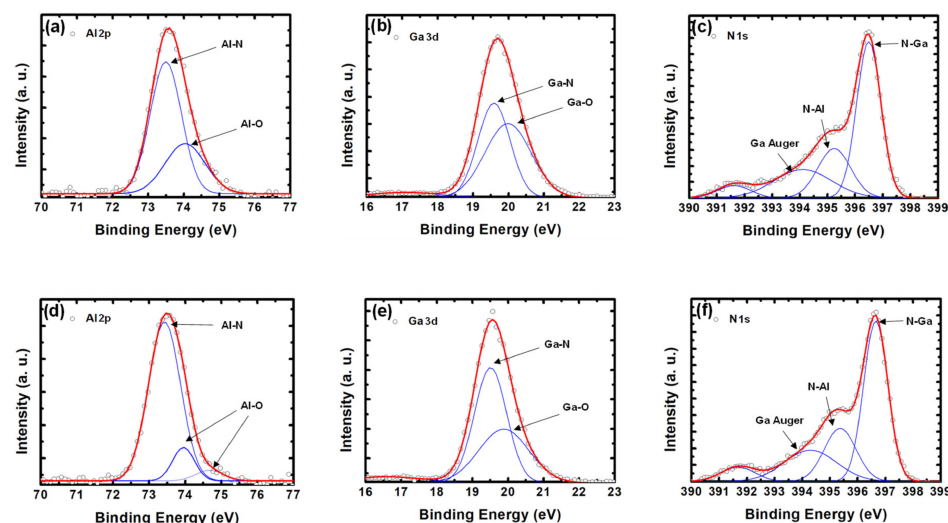
Figure 10. XPS fitting results of the Al 2 p , Ga 3 d , and N 1 s peaks for the AlGaN samples fabricated using the digital etching ( a – c ) and ALE ( d – f ) processes.